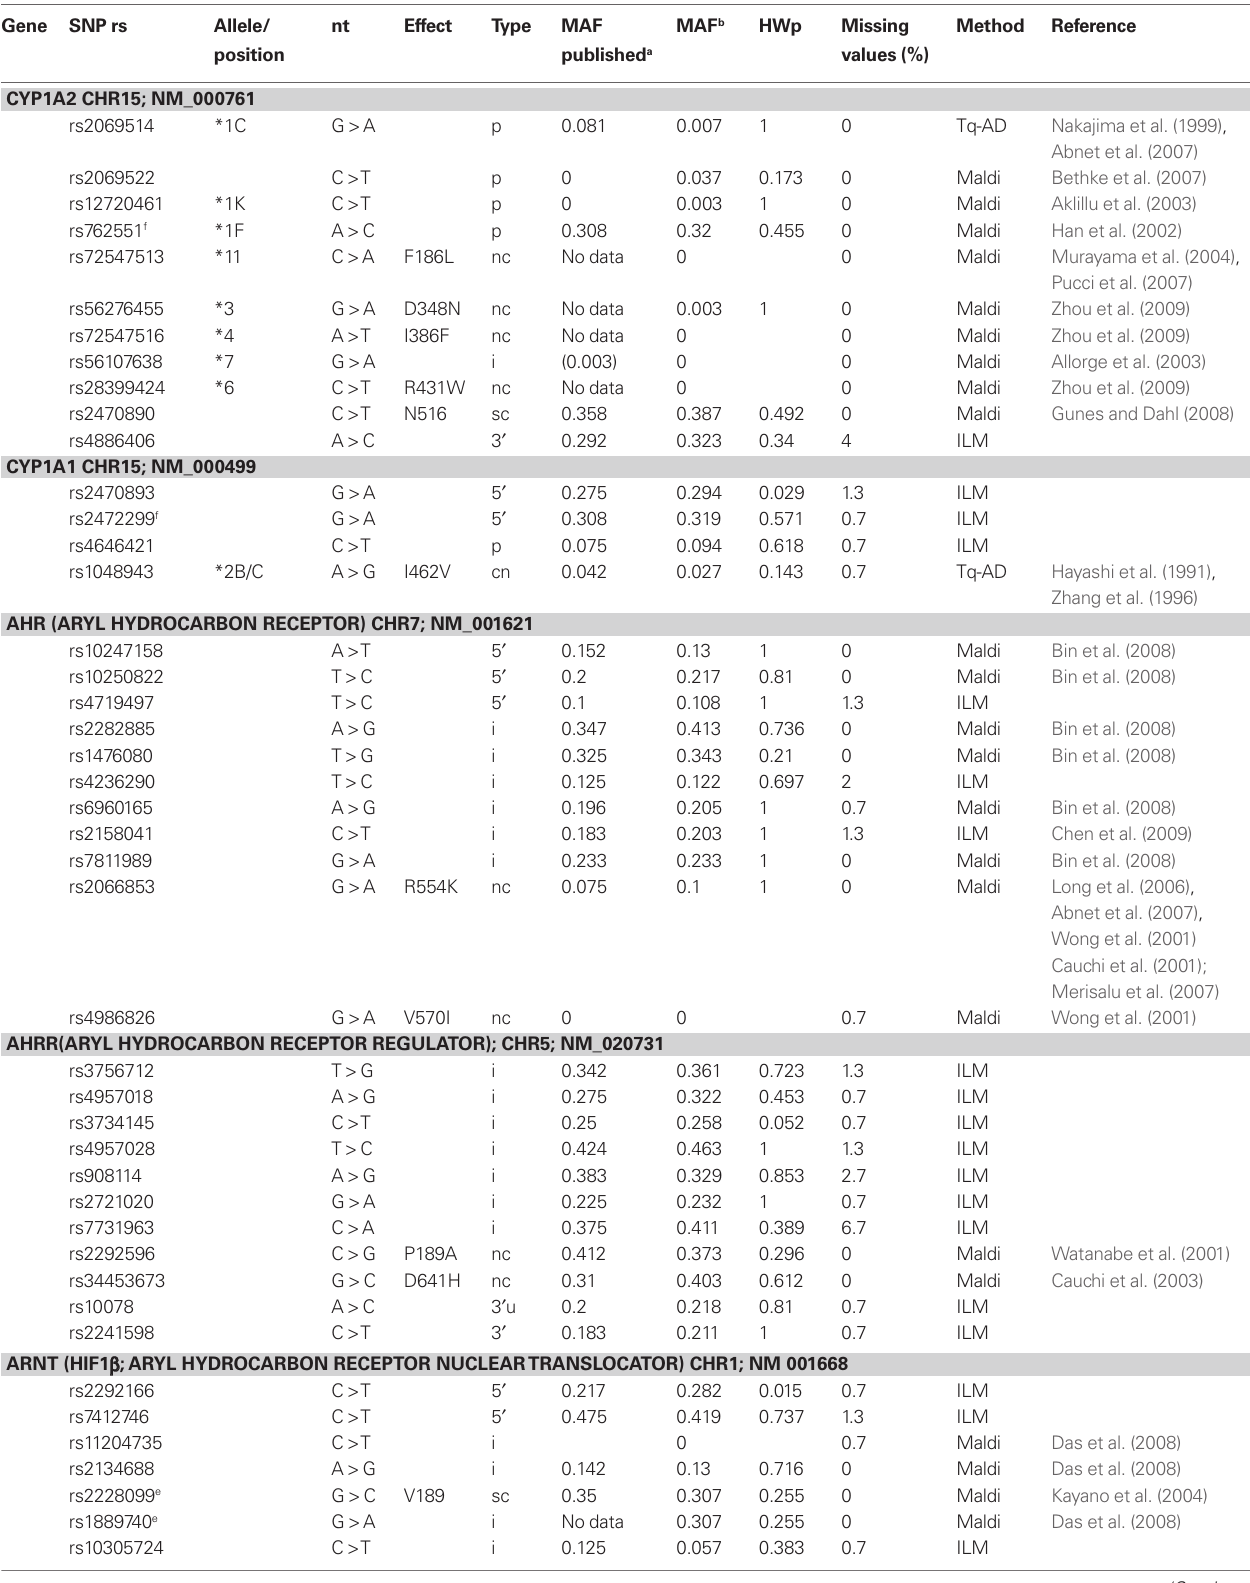
Table S1 | included SNPs, genotyping methods and frequencies. gene SNP rs